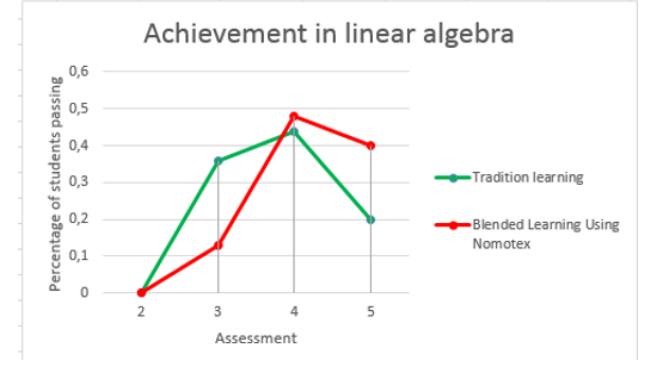
Fig. 2. Achievement in linear algebra.